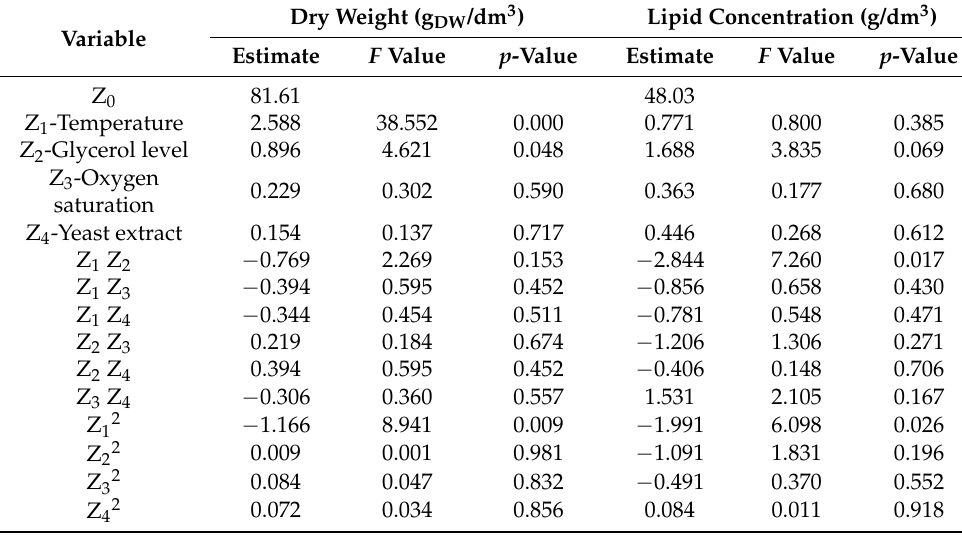
Table 10. Values of coefficients for the second-order polynomial